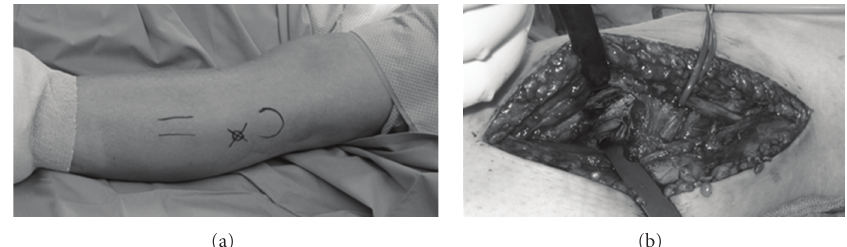
Figure 3: (a) The patient marked the most painful side distal to the fibular head. (b) The common peroneal nerve is in anatomical proximity to the tumor location.